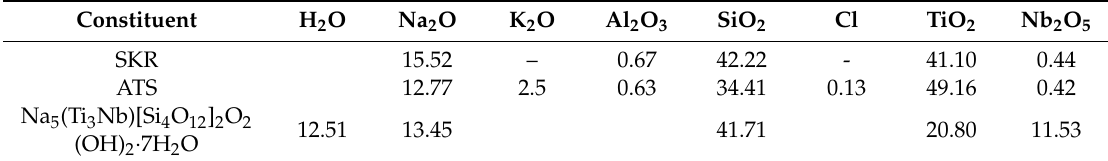
Table 3. Chemical composition of co-existing SKR and ATS.